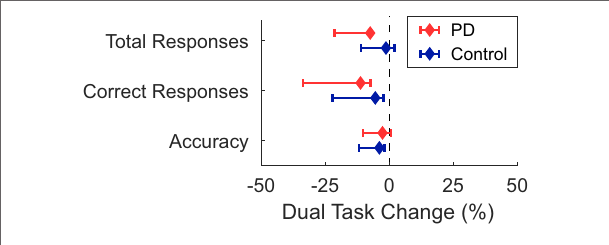
FigUre 3 | Median dual-task changes (DTC) as percentages (%DTC) and IQRs for cognitive outcomes for people with Parkinson’s disease (PD) (red) and healthy control subjects (blue). DTCs were calculated as a percentage change with respect to seated. Group differences in DTCs as percentages were not tested for any cognitive outcome as no group*task interactions were significant in the initial linear mixed models.